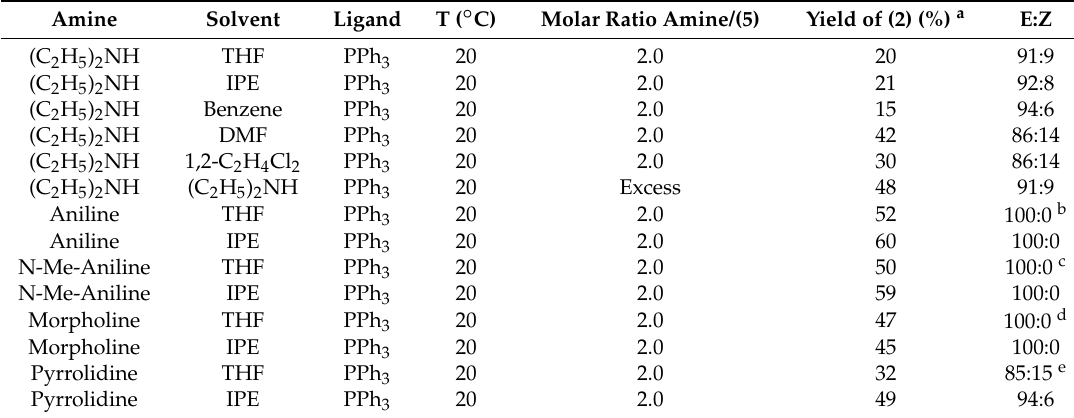
Table 7. Pd(0)-catalyzed amination of linalyl methylcarbonate ( 5 ). Adapted from [91].